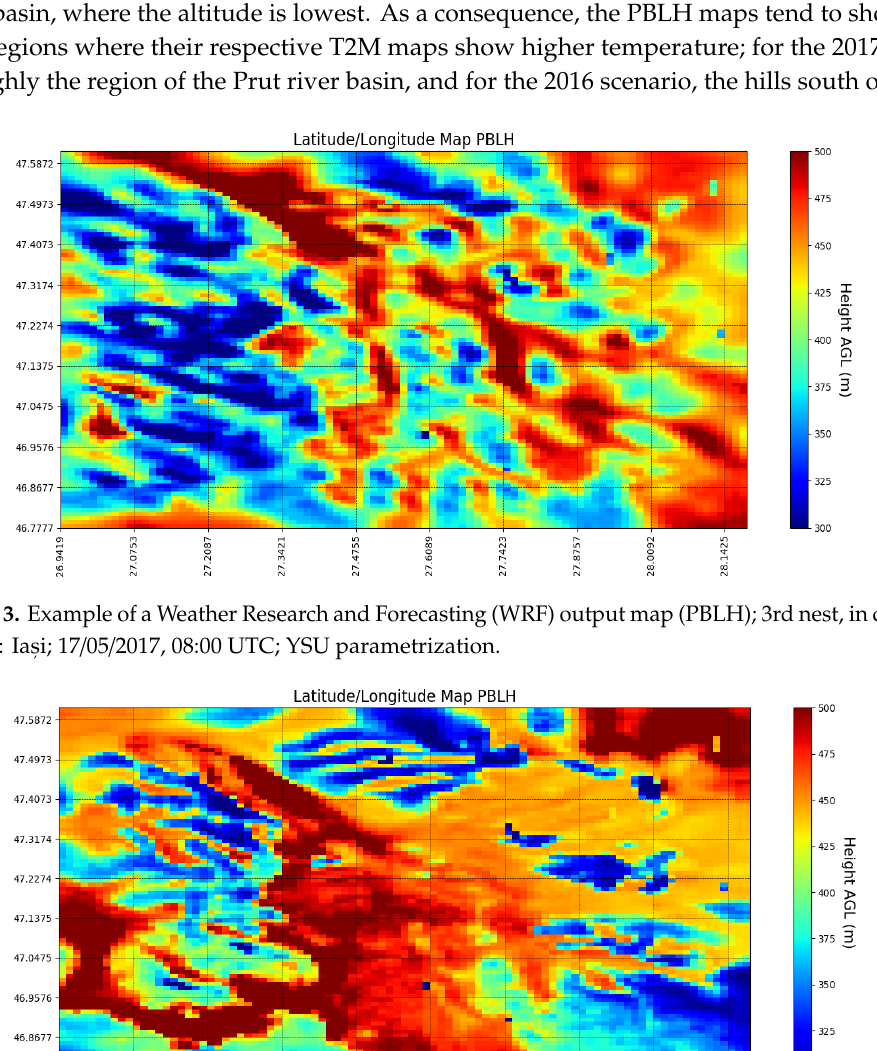
i; 04 / 04 / 2016, 08:00 UTC; ,